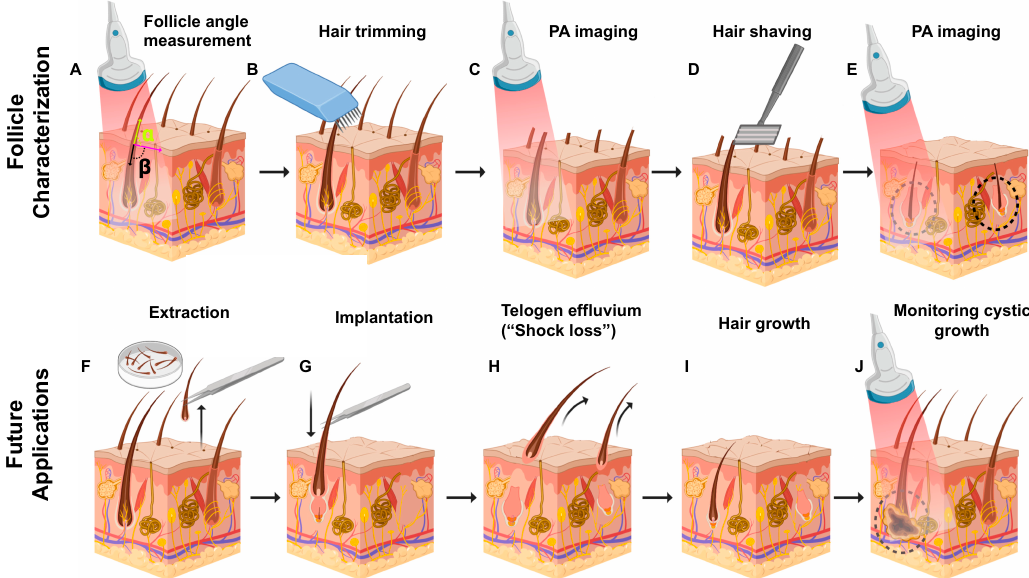
Figure 1. Photoacoustic imaging of follicular organization. The upper panel shows current work. ( A ) The follicular angle under the skin can be determined using photoacoustic imaging (PAI). ( B ) Hair trimming, ( D ) shaving, and subsequent ( C , E ) PA imaging to detect individual hair follicles, subdermal roots, and follicular angles. Future applications in follicular unit extraction and transplantation (FUE and FUT). ( F ) Hair follicles are excised from a safe donor area. ( G ) Extracted follicles are implanted in the donor spot. ( H ) Original hair shaft sheds while the dermal papilla is retained in a process called telogen effluvium (“shock loss”). PAI can quickly confirm successful implantation by imaging hair growth within the papilla before the follicle is visible on the skin surface. ( I ) Hair growth from successfully transplanted follicles. ( J ) Follicles implanted too deep can result in cyst formations 1–2 years after the procedure. PA imaging can monitor this cystic growth.